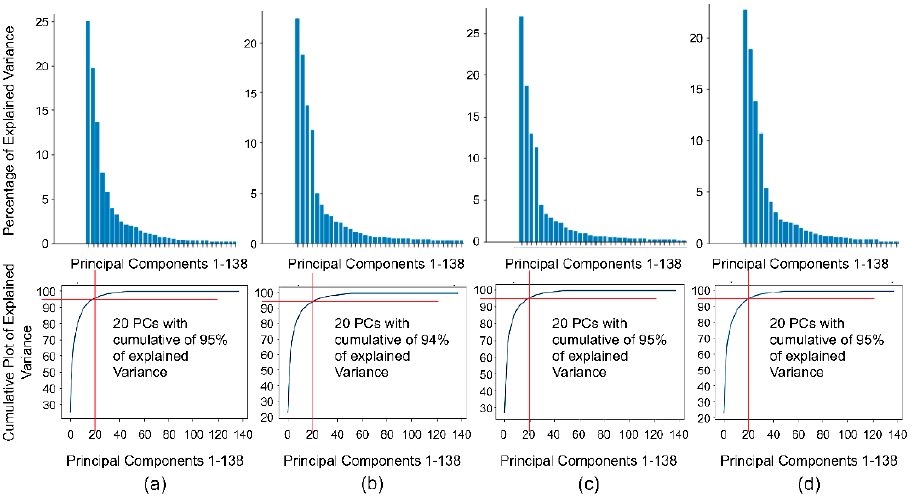
Figure 4. Scree and cumulative plots showing the percentage of explained variance by each principal component (PC) in the ( a ) warm-wet, ( b ) cold-dry, ( c ) cold-wet and ( d ) cold-dry seasons. The red line shows the explained variance corresponding to 20 principal components.